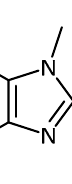
Figure 17. Structure of huperzine A.